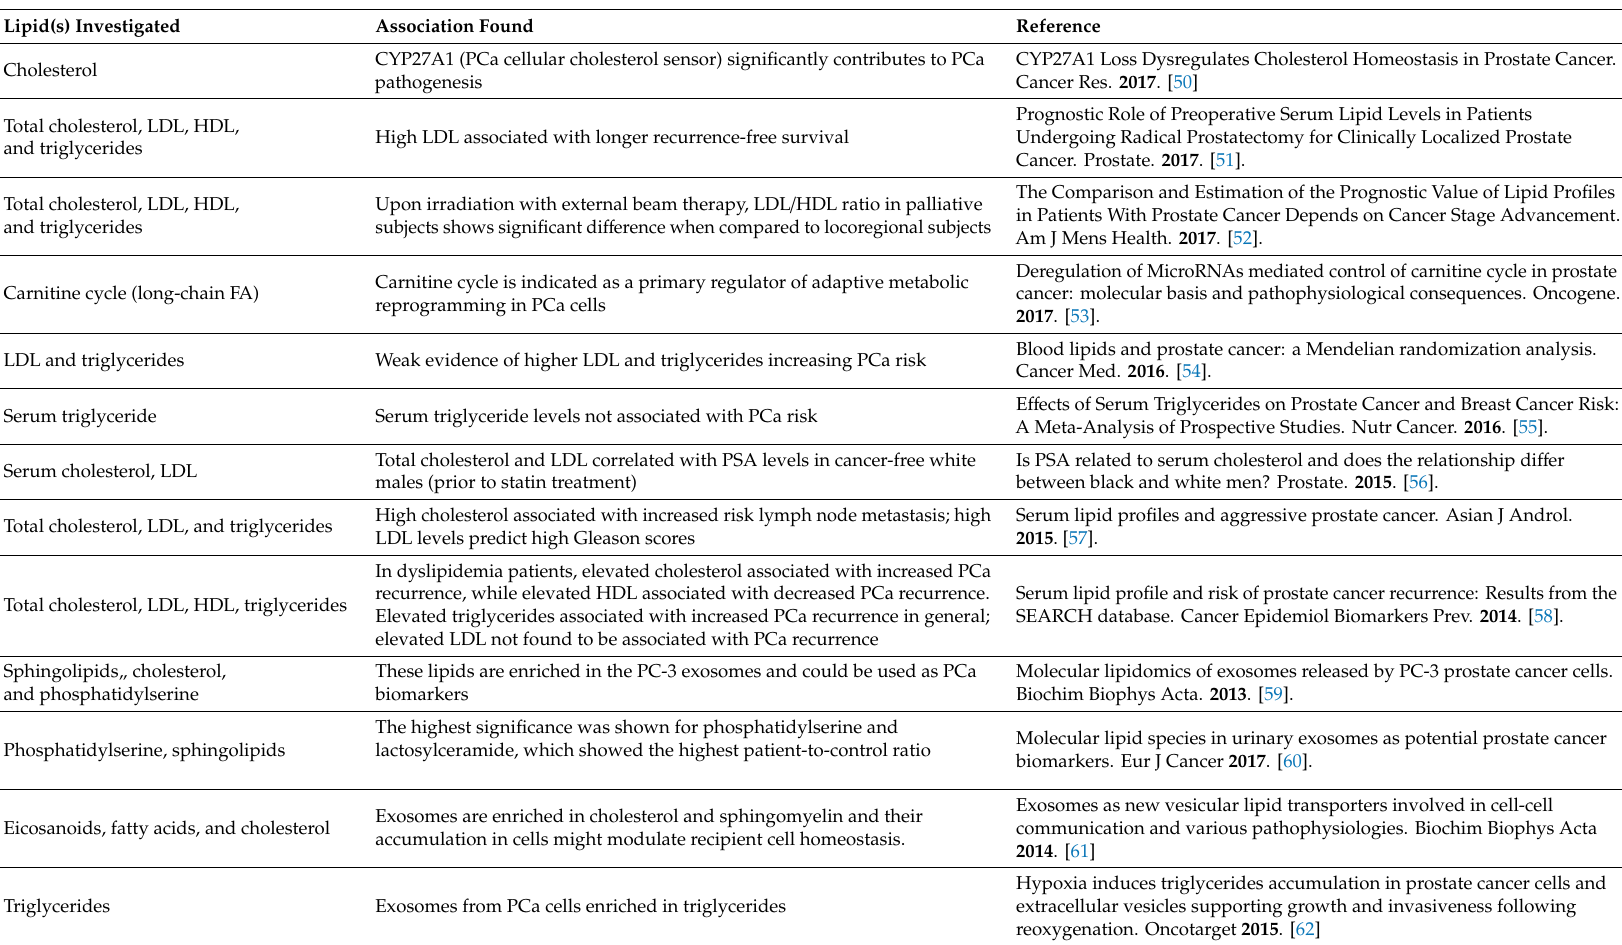
Table 2. Representative studies of associations between lipoproteins, exosomes, cholesterol delivery, and